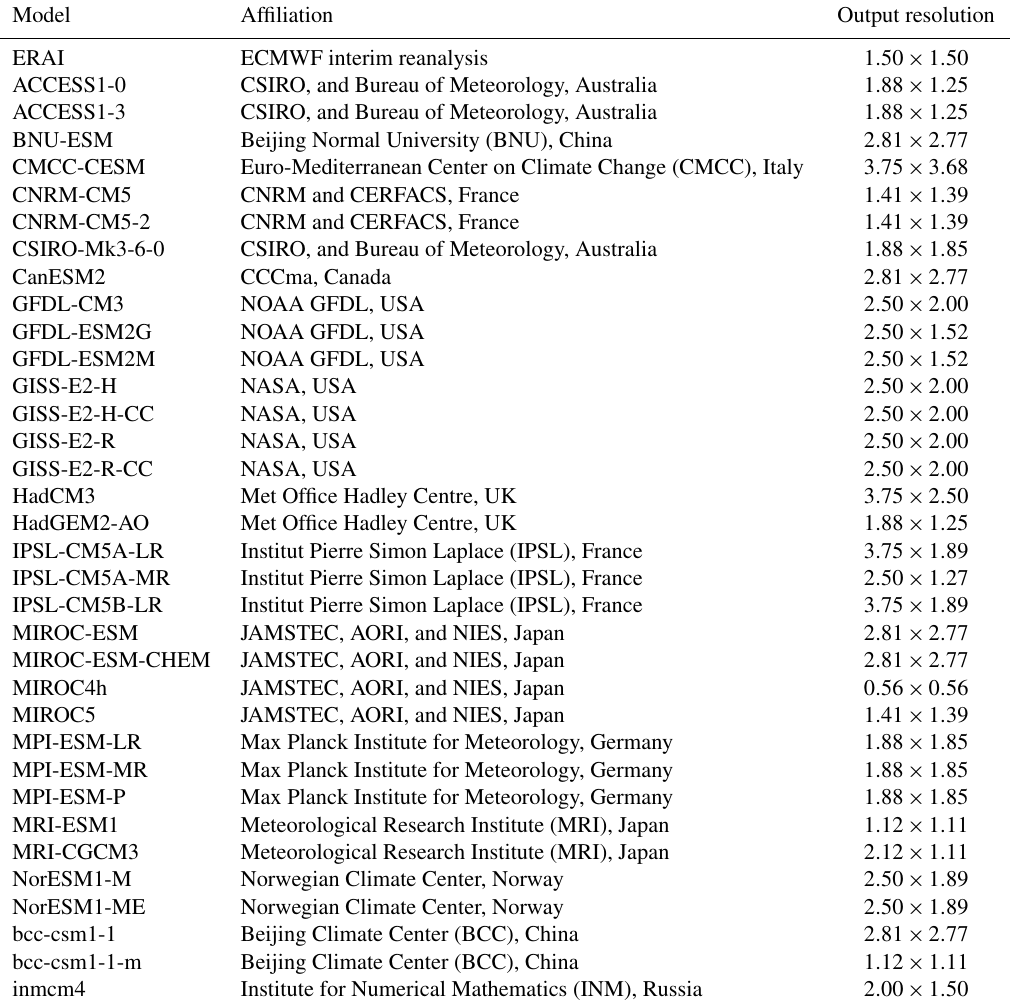
Table 1. ERAI and CMIP5 models’ affiliations and the horizontal resolution of the analyzed data (long ◦ × lat ◦ ). The first ensemble member (“r1i1p1”) is used from each CMIP5